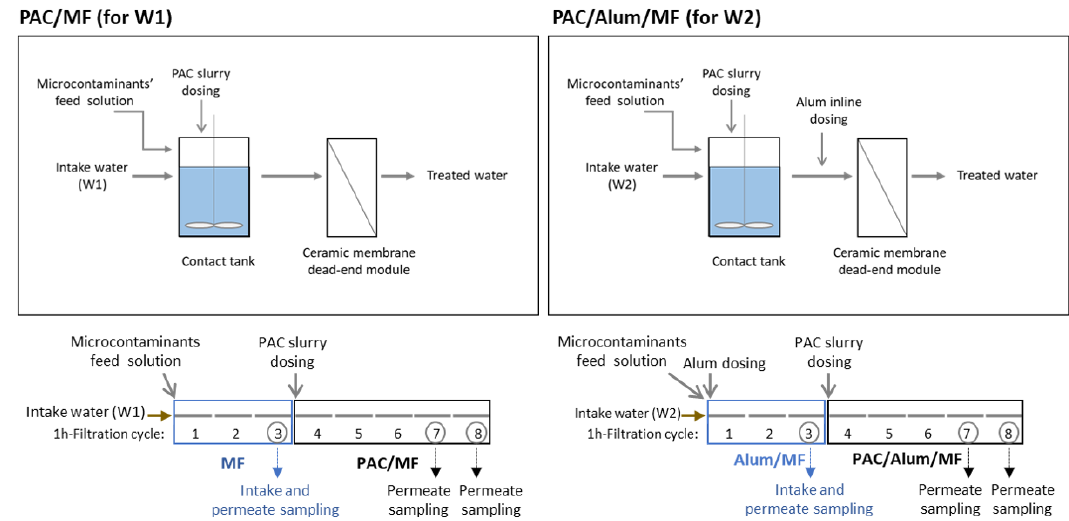
Figure 1. Scheme of powdered activated carbon/(coagulation)/microfiltration process, i.e., PAC/MF for intake water W1 and PAC/Alum/MF for intake water W2 ( top ) and of the respective spiking trials’ procedure ( bottom ) (8 × 1-h filtration cycles, being 3 cycles without PAC and 5 cycles with PAC dosing).